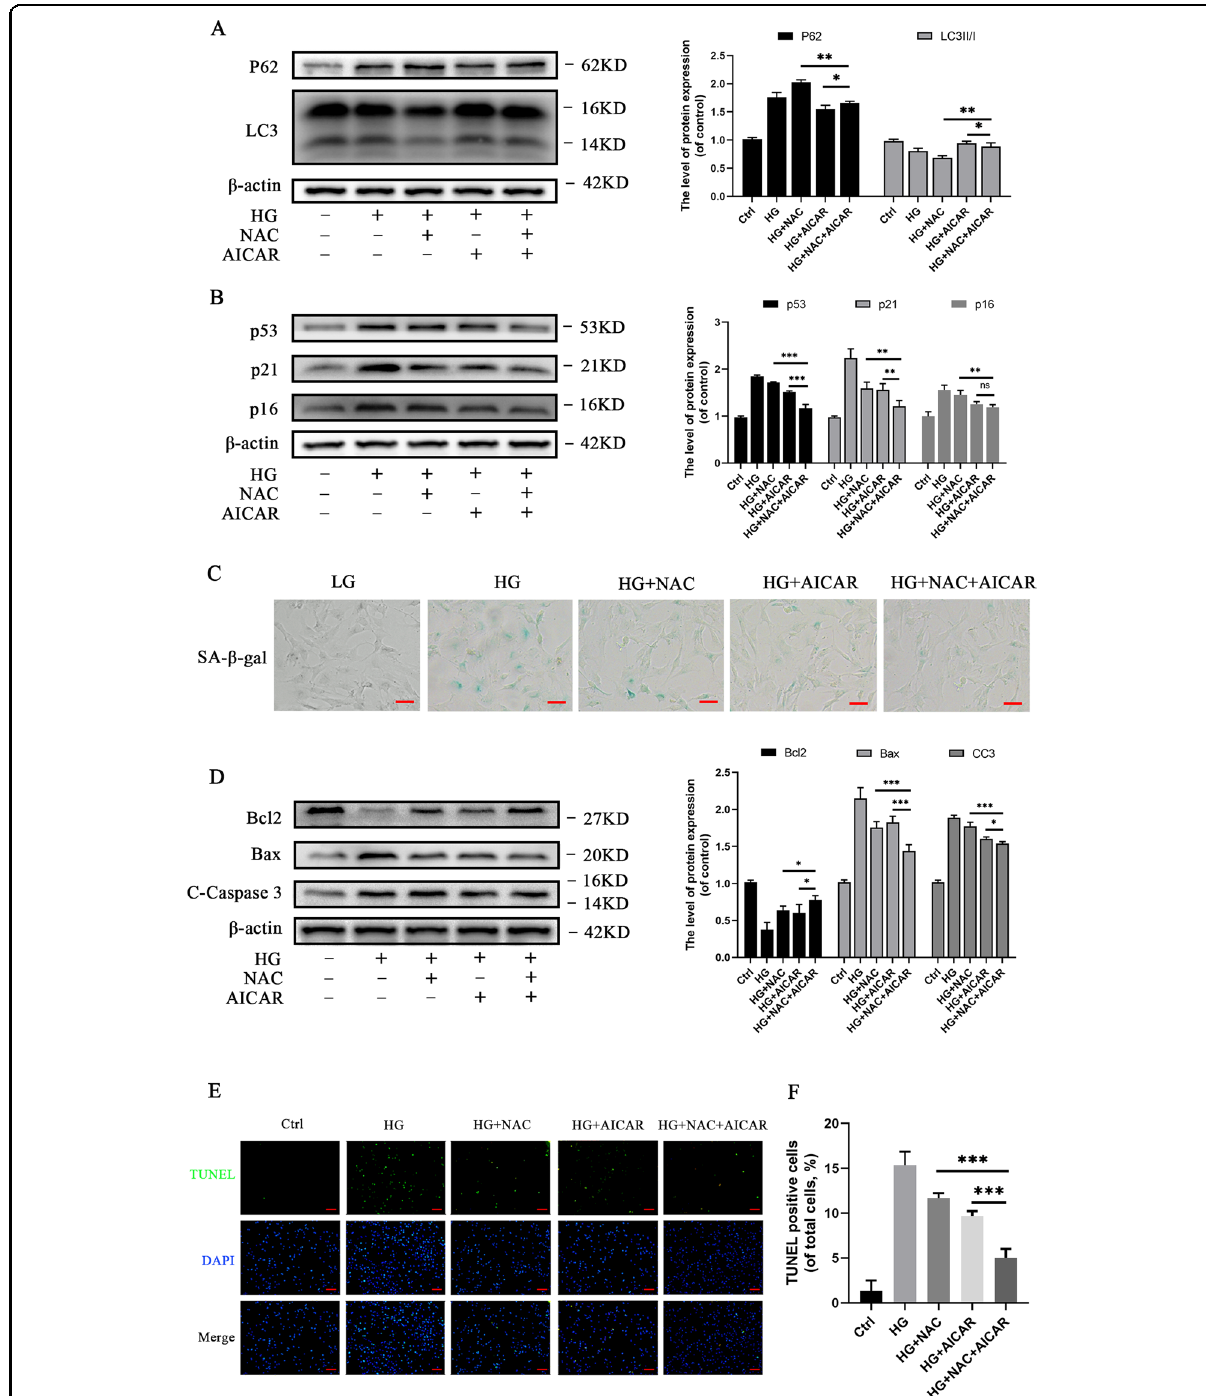
Fig. 5 Dual modulation effects of oxidative stress and AMPK (NAC + AICAR) suppresses apoptosis and senescence (2 + 2DG) in chondrocytes. A Western blot results and quanti fi cation analyses of p62 and LC3 in various treatment groups. B Western blot results and quanti fi cation analyses of p53, p21, and p16 in various treatment groups. C Representative micrographs of SA ‐ β ‐ gal staining of chondrocytes in various treatment groups. Scale bar = 50 μ M. D Western blot results and quanti fi cation analyses of Bcl2, Bax, and cleaved caspase-3 in various treatment groups. E Representative micrographs of TUNEL staining of chondrocytes to evaluate effects on apoptosis in various treatment groups. Scale bar = 100 μ M. F TUNEL-positive cell intensity in various treatment groups. Data are presented as means ± SD ( n = 5). * P < 0.05, ** P < 0.01, and *** P <